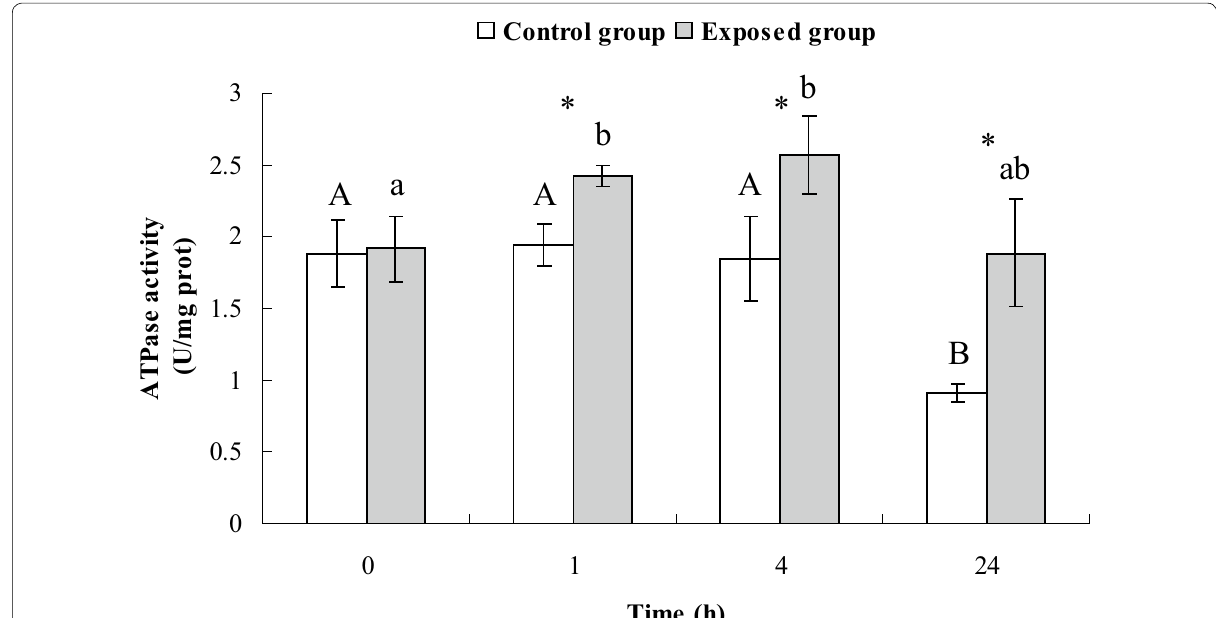
Fig. 1 ATPase activities of E. coli CFT073 in control group and exposed group. Different small letters indicate significant differences in the exposed group among different times (P < 0.05); different capital letters indicate significant differences in control group among different times (P < 0.05); the asterisk indicates significant differences between the control group and exposed group at the same moment (P < 0.05), and bars represent standard deviations of the means, the same below